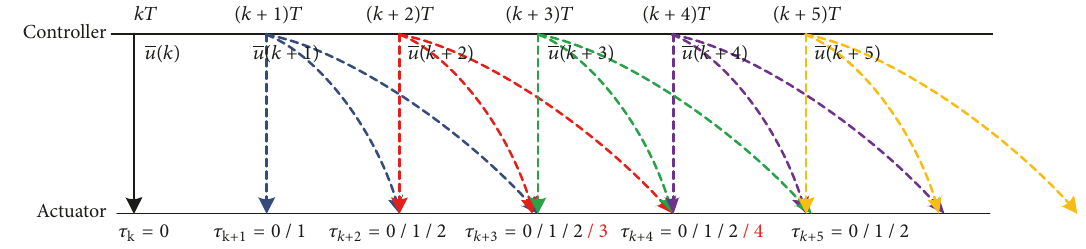
Figure 1: Signal transmission timing diagram with 𝜏 max = 2 , 𝜌 max = 2